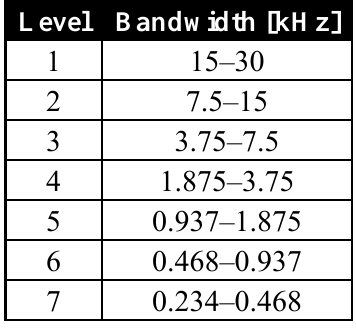
Table 1. Frequency bandwidths.